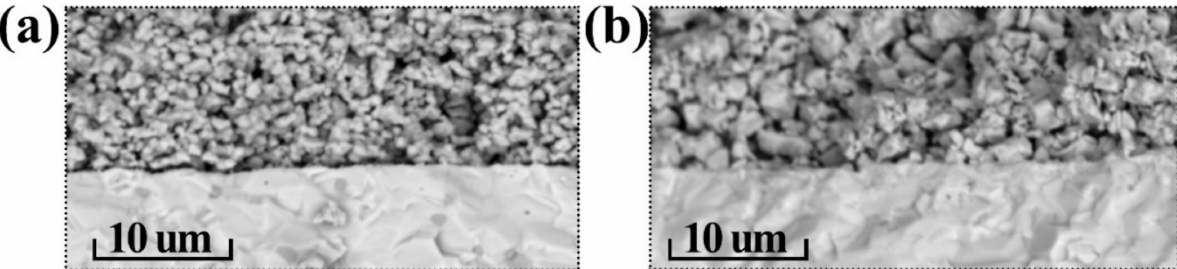
Figure 6. SEM analysis of the PrNi 0.4 M 0.6 O 3– δ |BaCe 0.6 Zr 0.2 Y 0.2 O 3– δ interfaces for the prepared symmetrical cells: M = Fe ( a ) and M = Co ( b ).